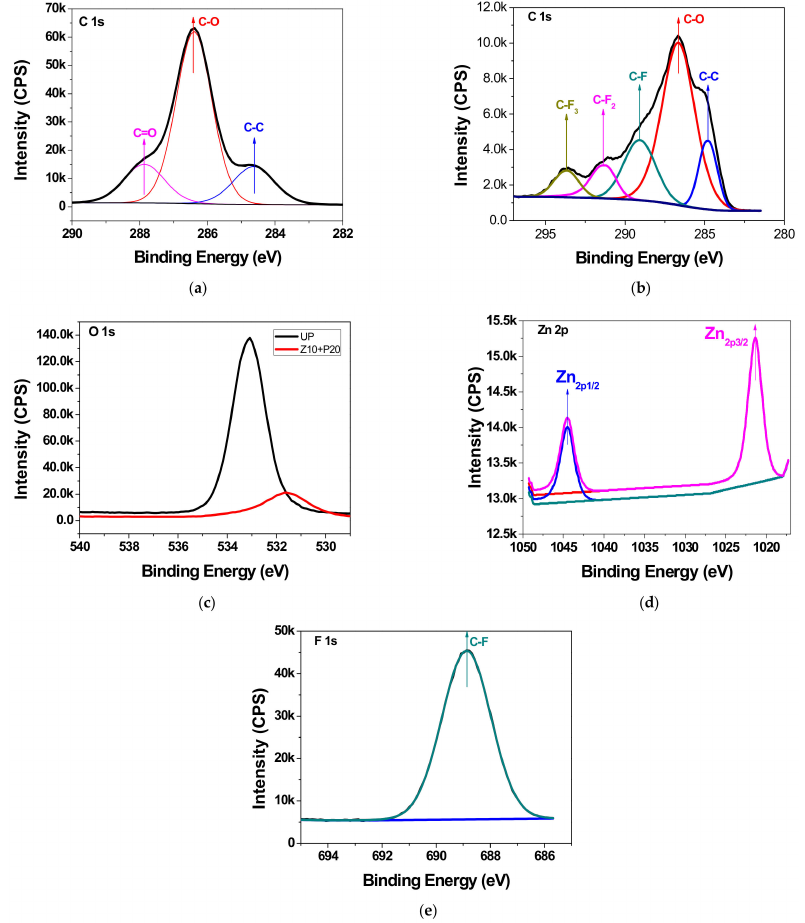
Figure 7. XPS resolution spectra of ( a ) C 1s for UP, ( b ) C 1s for Z10 + P20, ( c ) O 1s for UP and Z10 + P20, ( d ) Zn 2p for Z10 + P20, and ( e ) F 1s for Z10 +